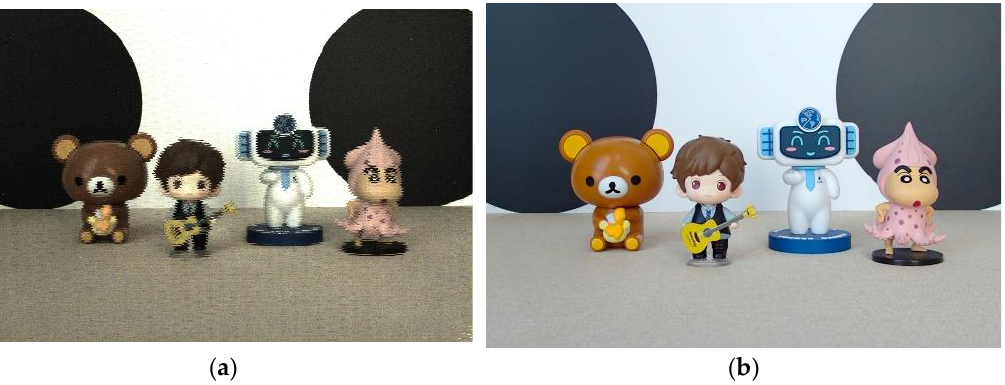
Figure 4. Scene 3 light field full-focus image. ( a ) The original images of the light field. ( b ) The full- focus images of the light field.